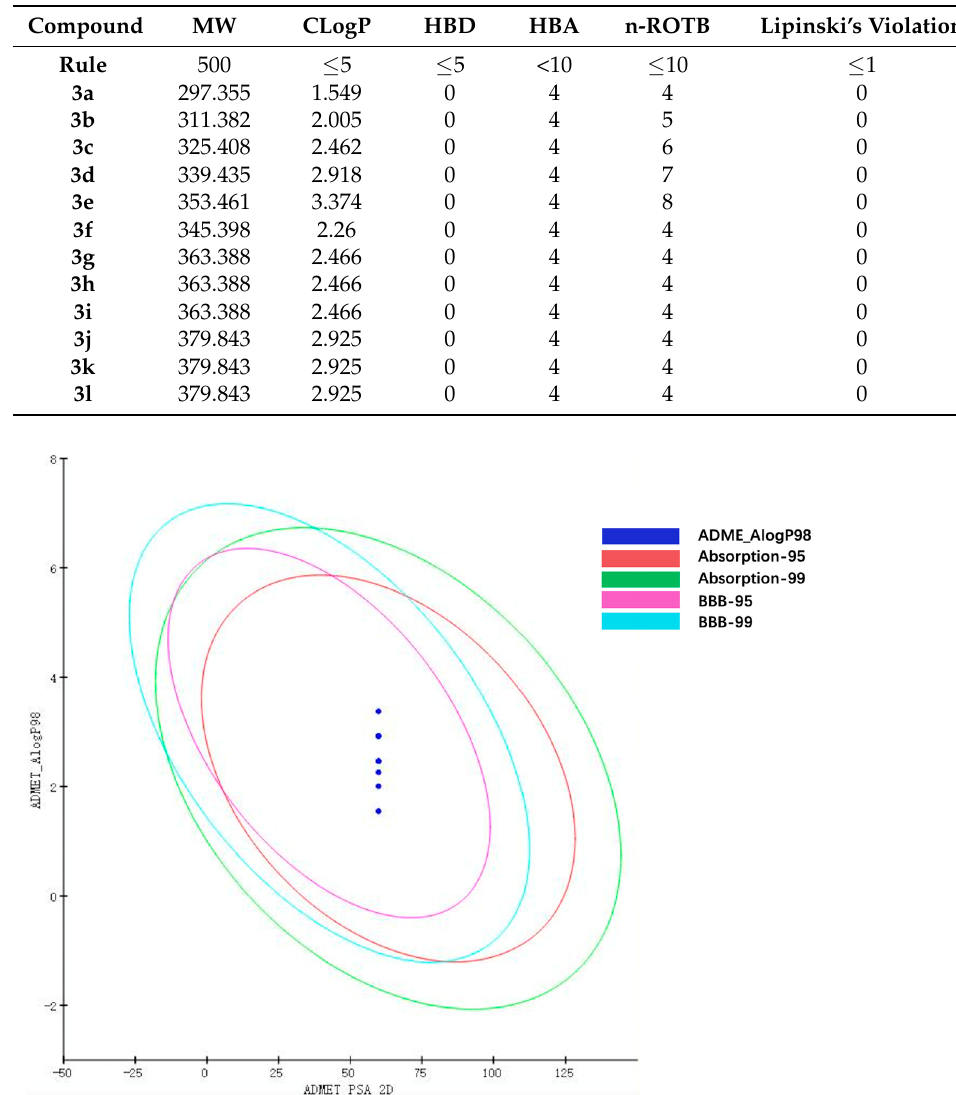
Table 3. Drug-like property parameters of the target compounds 3a – l .